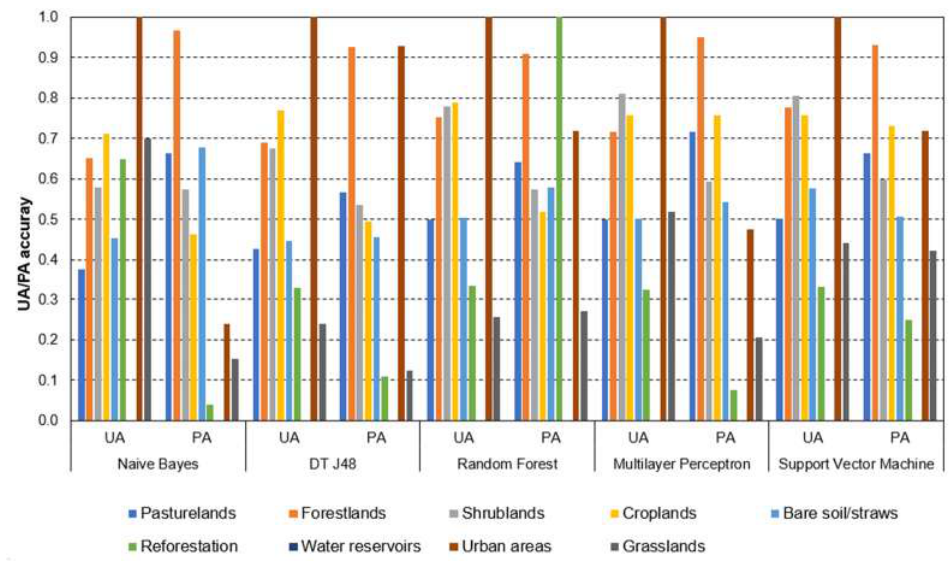
Figure 5. Conditional Kappa indices of the user’s accuracy (UA) and producer’s accuracy (PA) considering training sets of 200 samples for each classifier.